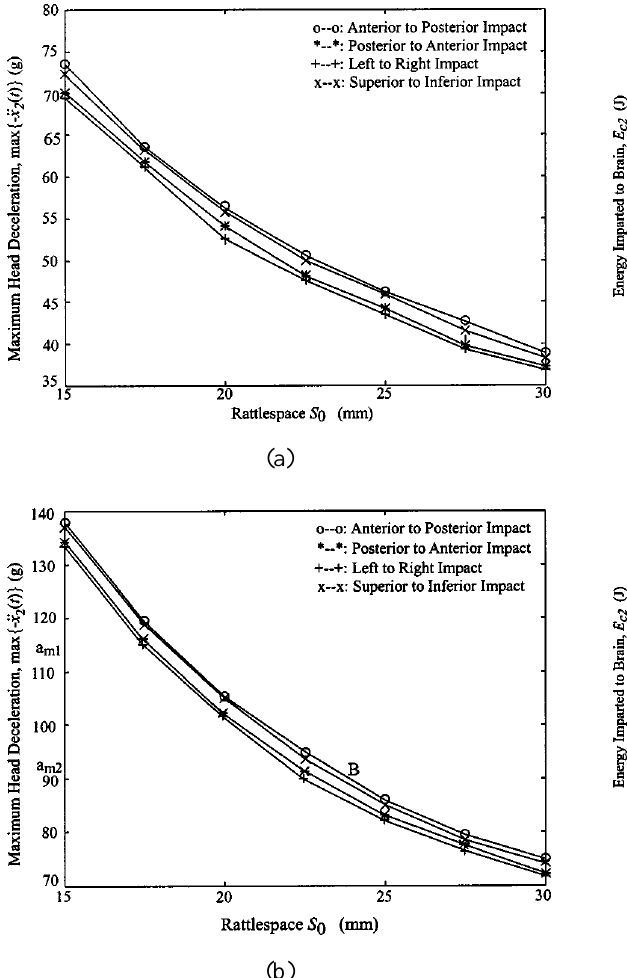
Fig. 10. Trade-off curves for Case 2 (minimize the energy imparted Fig. 9. Trade-off curves for Case 1 (minimize the peak head acceler- to the brain): (a) E 0 = 53 : 4 J, (b) E 0 = 100 J. ation): (a) E 0 = 53 : 4 J, (b) E 0 = 100 J. (cid:15) A sudden jump (the initial impulse) of the con- the limiting performance of the helmet using a trol force at the onset of the impact would pro- SDOF head injury model was studied by mini- duce a very large rate of change of the head ac- mizing the maximum head acceleration, a con- celeration, the jerk, which could result in head in- stant head acceleration during impact was also jury too [16]. This is evident in Fig. 11(c), where obtained, and the corresponding optimal control the power developed in the skull has a sharp peak force is constant too. For the SDOF model, for a initially. given initial impact velocity v 0 and a prescribed (cid:15) If the impact is in the L–R direction and the rat- rattlespace S 0 , the maximum head acceleration tlespace is small (say, S 0 = 15 mm), the con- a m is given by a m = v 2 =S 0 , that is, the maximum 0 6 straint on the energy imparted to the brain ( E c head acceleration is proportional to the square of 2 6 0 : 5251 J for 0 : 2334 J for E 0 = 53 : 4 J and E c the initial impact velocity or to the initial impact 2 E 0 = 100 J) is an inconsistent constraint, that is, energy. Also, for Case 1, the peak head accelera- it cannot be satisfied in the optimization compu- =S 0 . The peak tion is given by max t j (cid:127) x 2 ( t ) j (cid:25) v 2 0 tation. When this happens, the constraint can be head accelerations for the various impact direc- tions are very close, as shown in Figs 9(a) and (b).